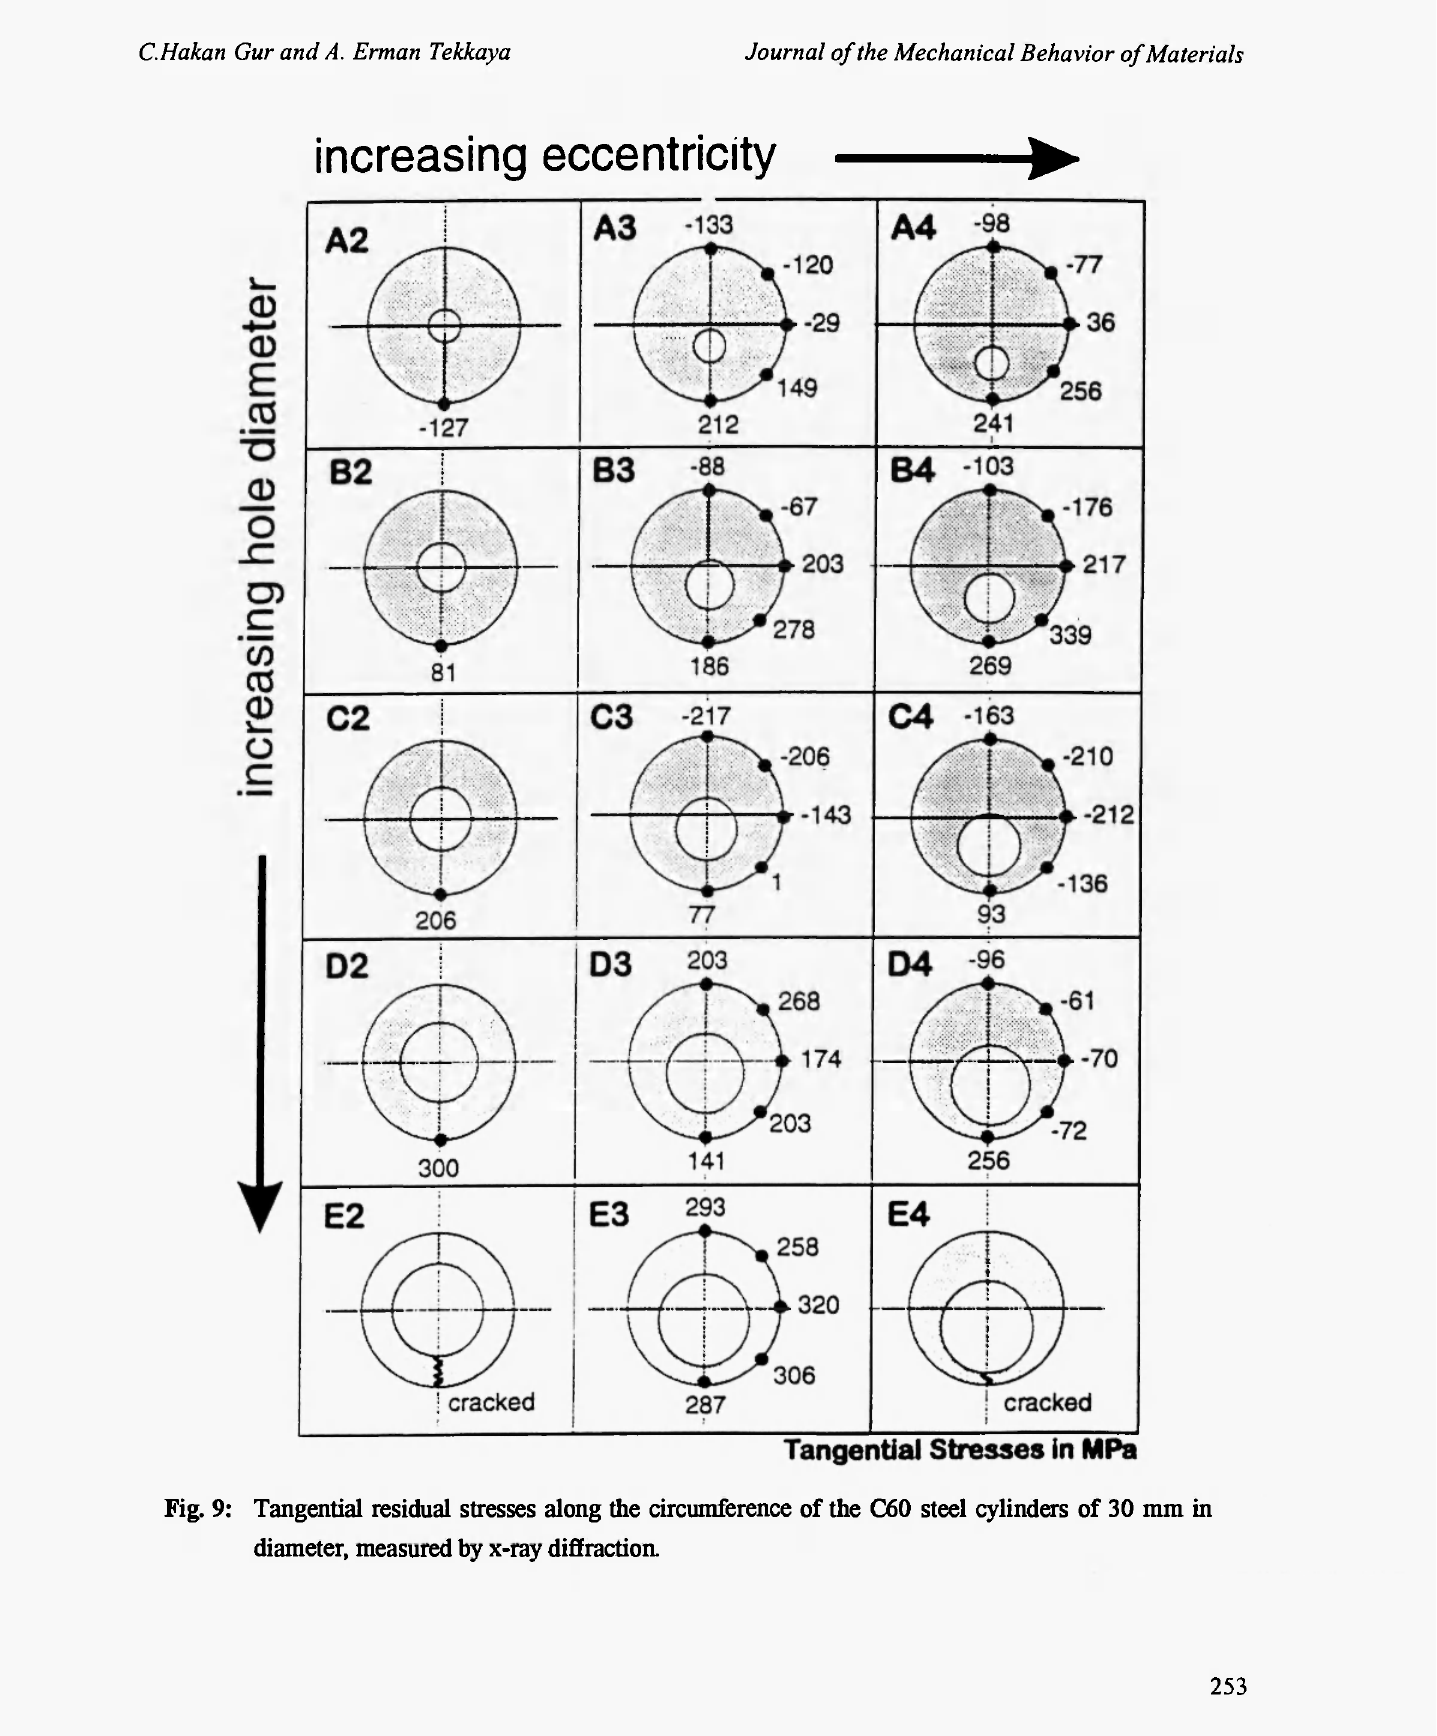
Fig. 9: Tangential residual stresses along the circumference of the C60 steel cylinders of 30 mm in diameter, measured by x-ray